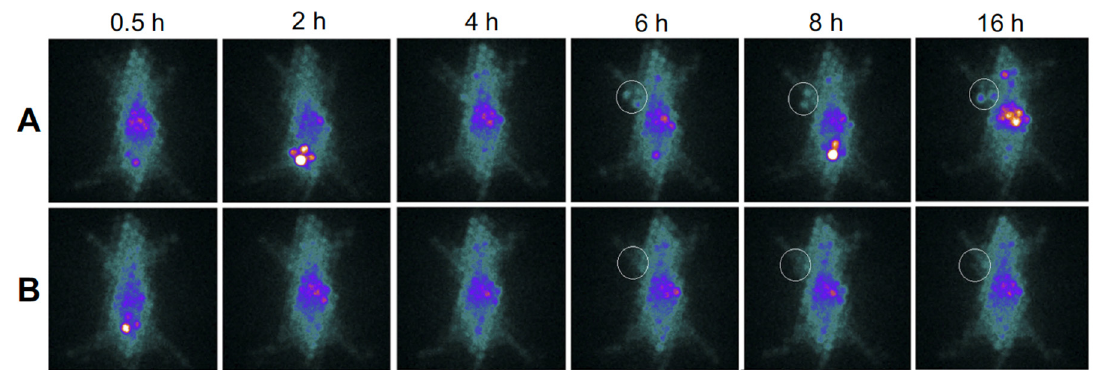
Figure 13. SPECT images of mice treated with ( A ) BmK CT-Au PENPs- 131 I and ( B ) Au PENPs, respectively, at different time points post-injection. The tumor site is highlighted by white circle [156]. Similar results were obtained from the mice imaged using the CT system.